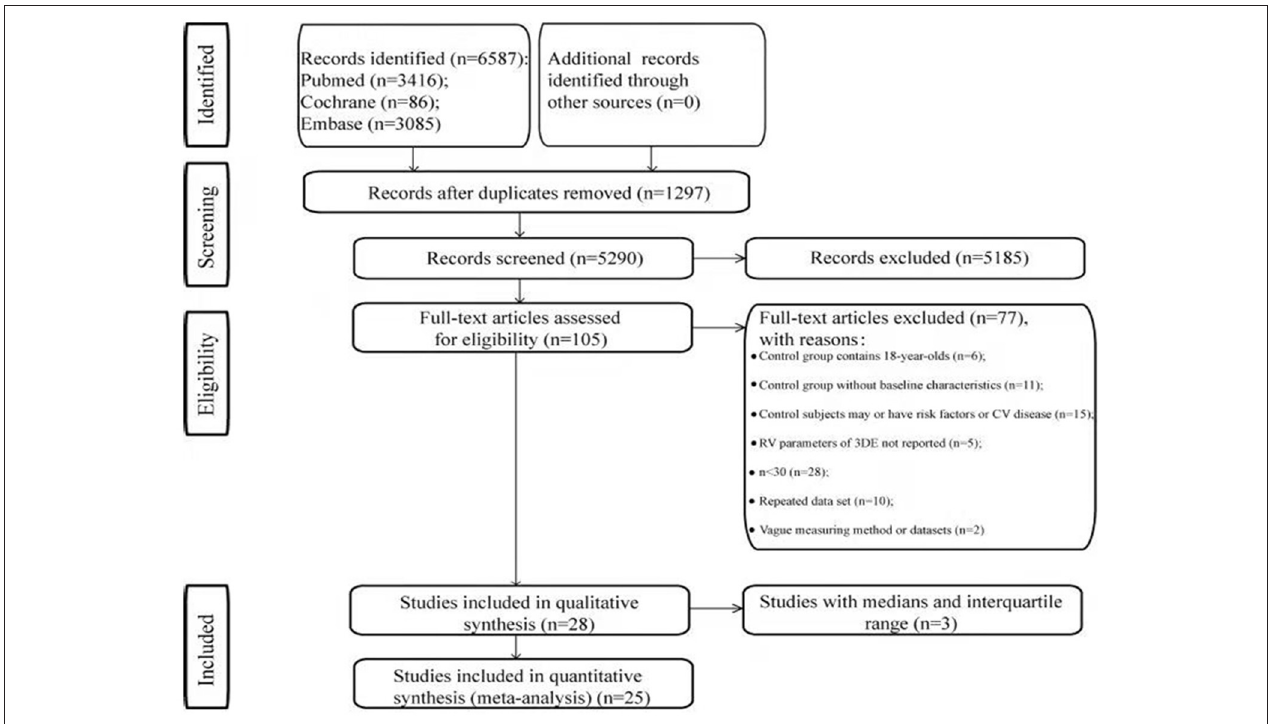
FIGURE 1 | Flowchart of the study selection